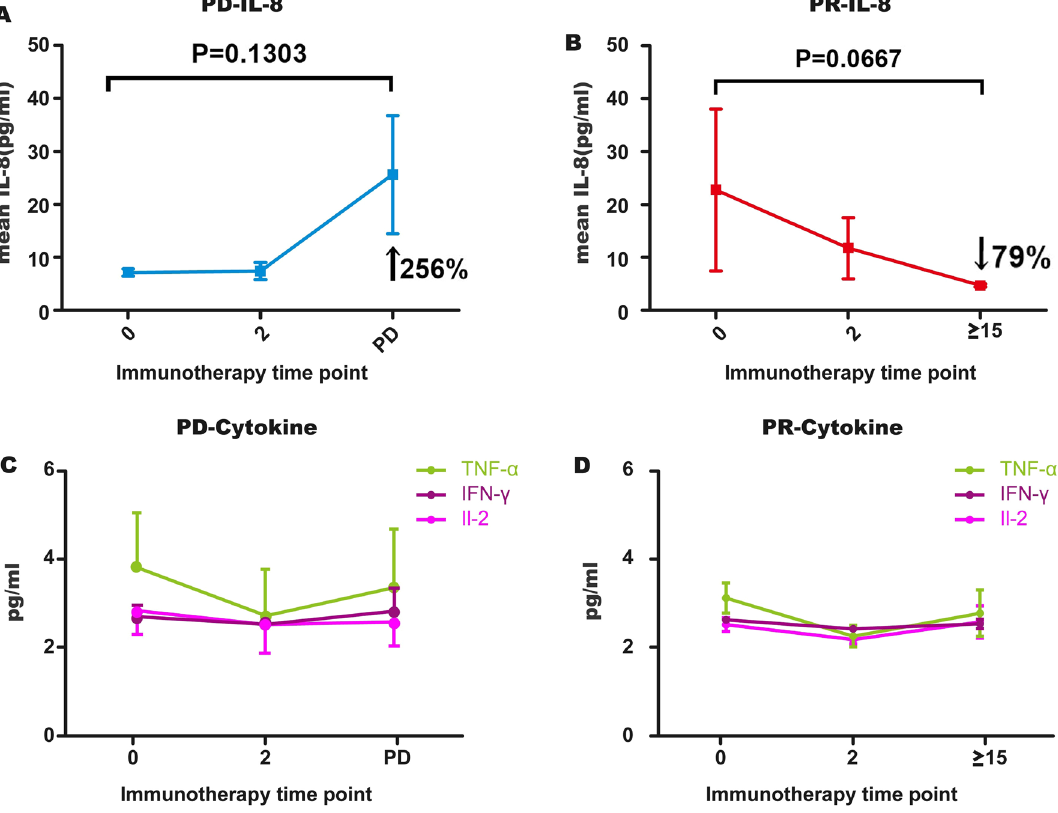
Fig. 4 Dynamic changes in cytokines during anti-PD-1 treatment. A , B Blood concentrations of IL8 were measured during anti-PD-1 treat- ment at baseline, at 2 cycles of treatment and at the time of progressive disease or more than 15 cycles of treatment. Lines show the trend of the Il-8 median value at each moment C , D , Changes in mean values of IL-2, TNF-α and IFN-г in PD and PR patients during anti-PD-1 treat- ment. All cytokines declined from baseline to 2 cycles and then rose